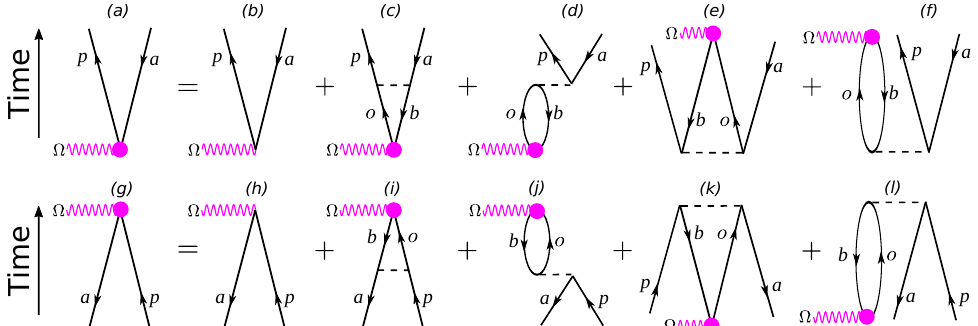
Figure 1. Goldstone diagrams illustrating RPAE for the many-body screening of the photon interac- tion. The set labelled with ( a , g ) are forward and backward propagation, respectively. Diagrams ( b , h ) are the lowest order contributions, while ( c – f ) and ( i – l ) give the many-body response. The sphere indicates the correlated interaction to infinite order. The wavy line indicates the photon interaction and the dashed line the Coulomb interaction. Downward lines (labelled with a, b) stand for holes created when electrons are removed from initially occupied orbitals, and upward lines (labelled with o, p) for initially unoccupied